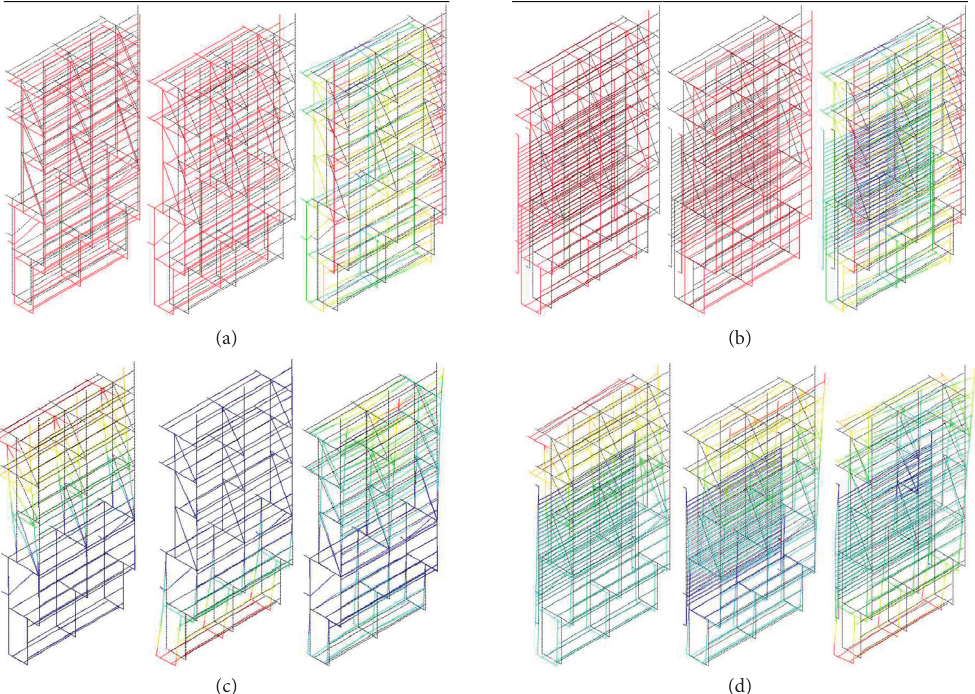
∗ The black line model stands for the original model, and the color line model stands for the mode shape.